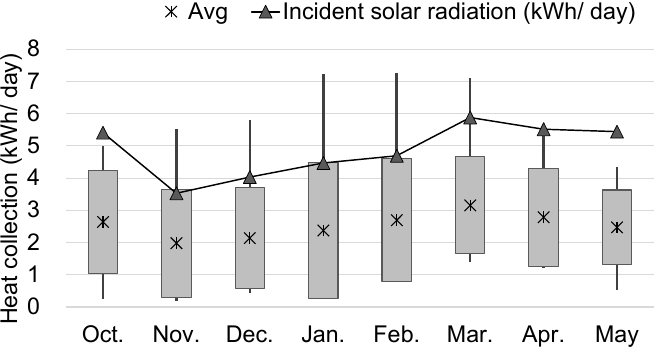
Figure 8. Heat collecting effect of two solar air heaters.